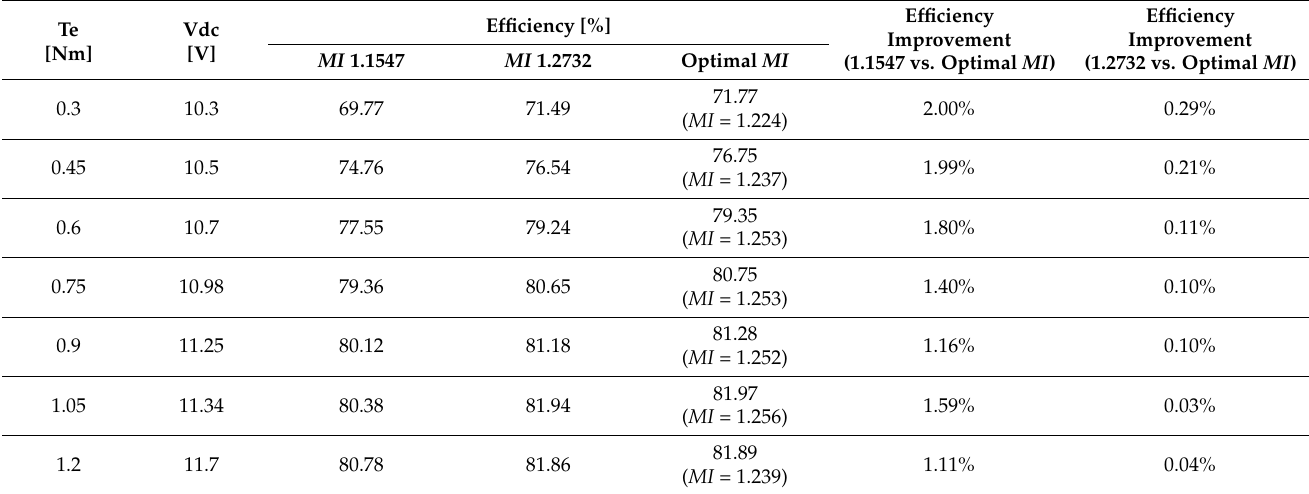
Table 1. Efficiency comparison results of optimal MI and fixed MI.